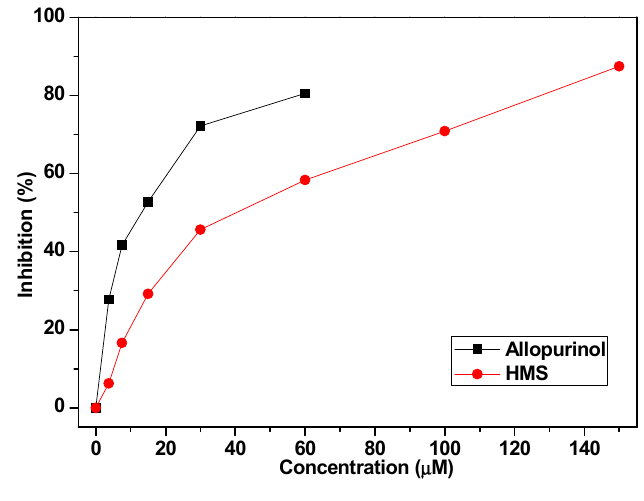
Figure 3. XOD inhibition of HMS.